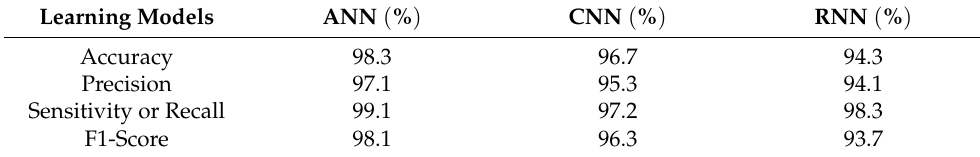
Table 3. Performance efficiency of the learning models with STL.